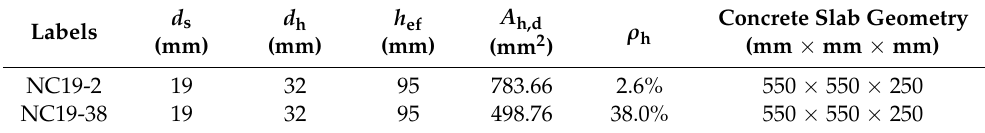
Table 1. Summary of specimens.